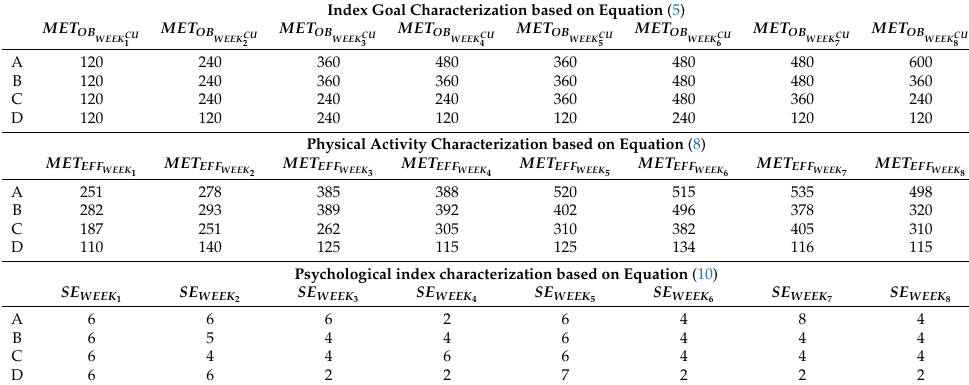
Table 2. Samples of input values for profiling users according to Equation